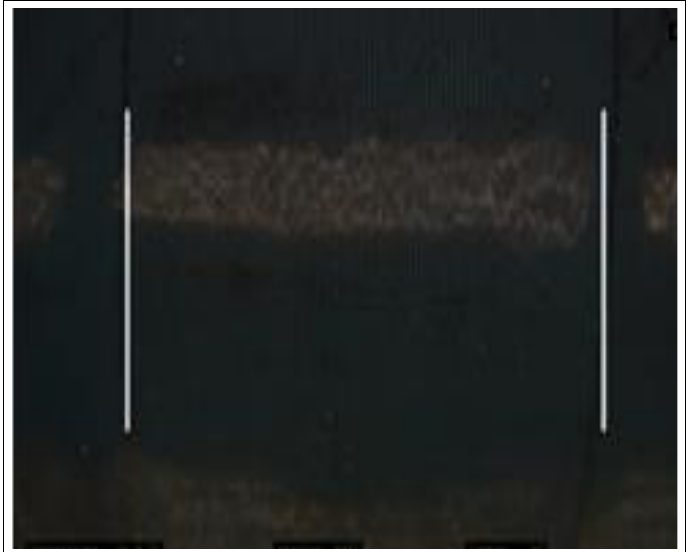
Figure 9. Output image with two identified parallel lines after applying OpenCv methods.